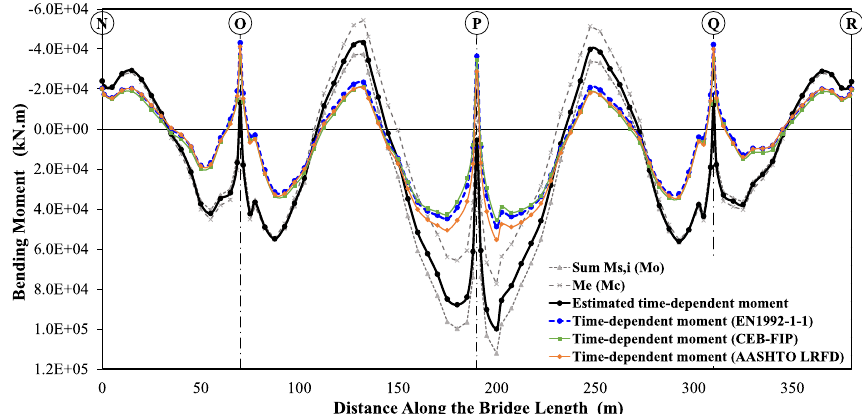
Fig. 8 Time-dependent moments from ‘real’ time history FE analysis versus estimated time-dependent moment from simplified approach–El Warrak